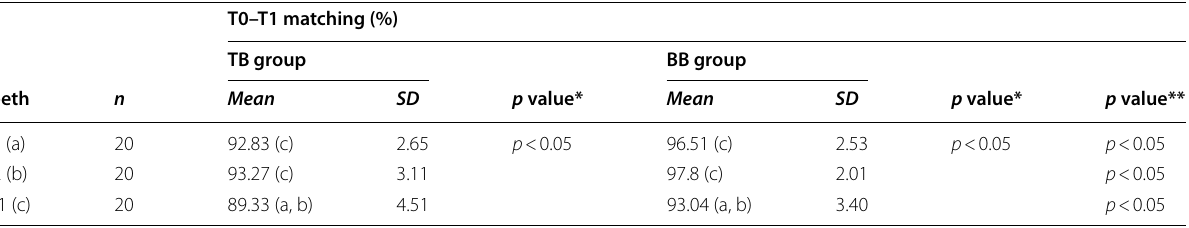
Table 3 Comparison of matching percentage of pre‑treatment and post‑retention radicular shells (T0–T1 superimposition) for each tooth investigated